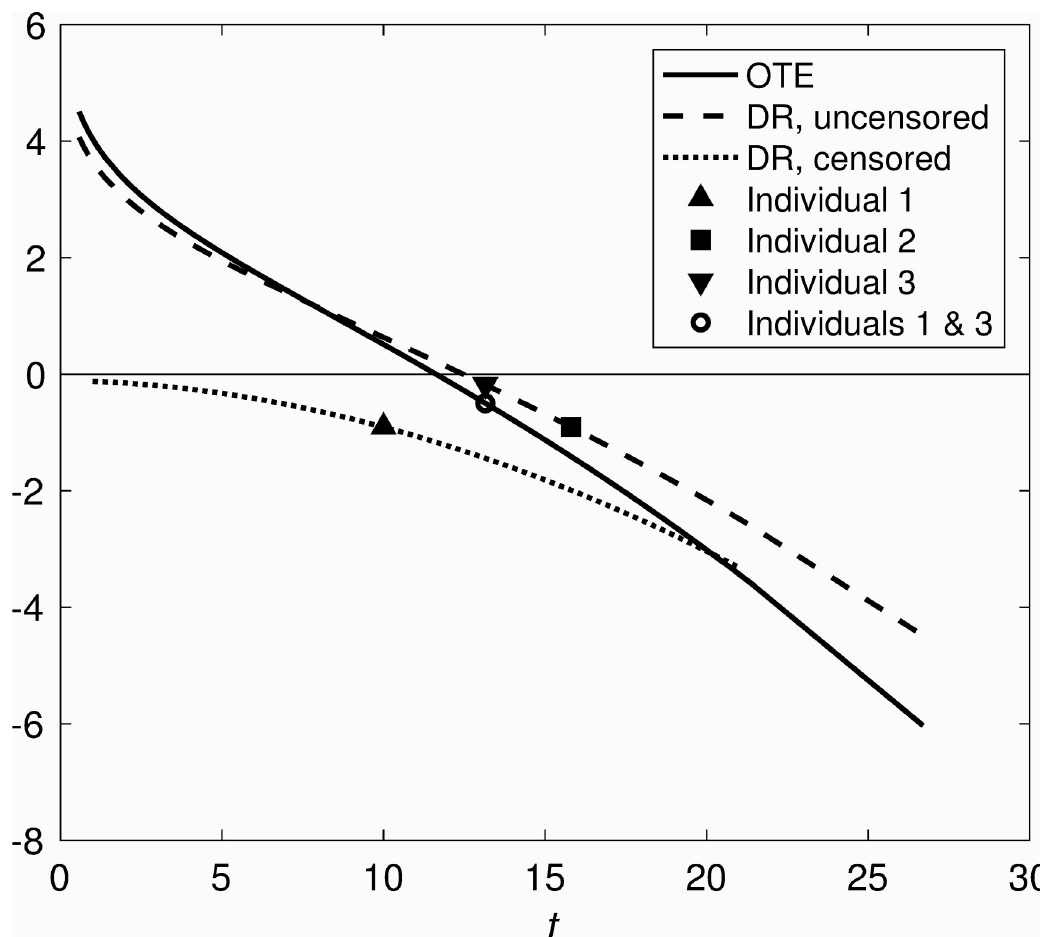
Fig 2. Illustration of key differences between DR and OTE. Calculations based on the same Weibull distribution used for Fig 1.